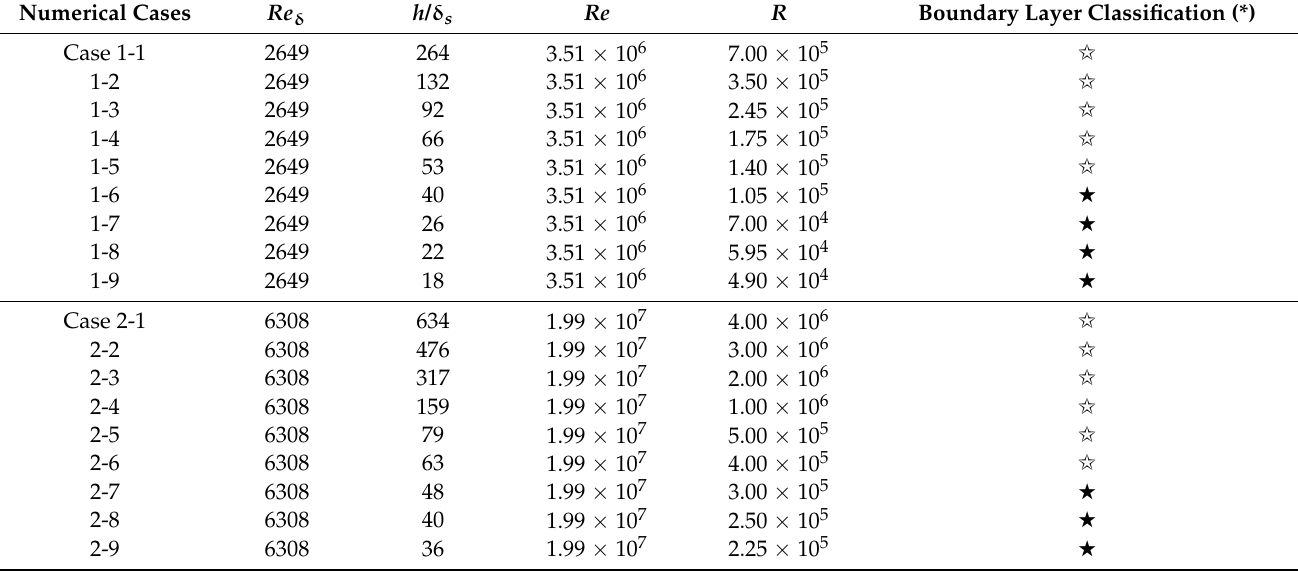
Table 2. List of the k - ω model simulation.